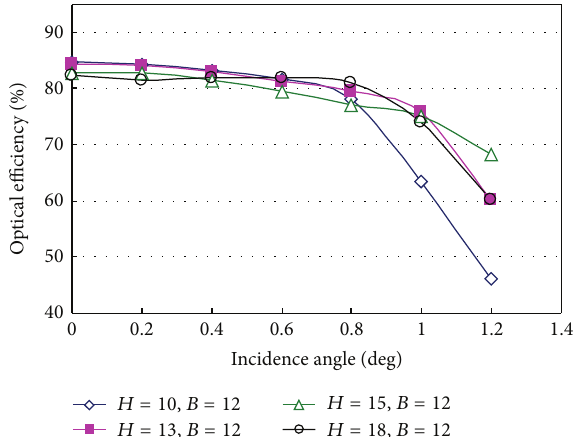
Figure 5: Optical efficiency with a refractive pyramid SOE under various incidence